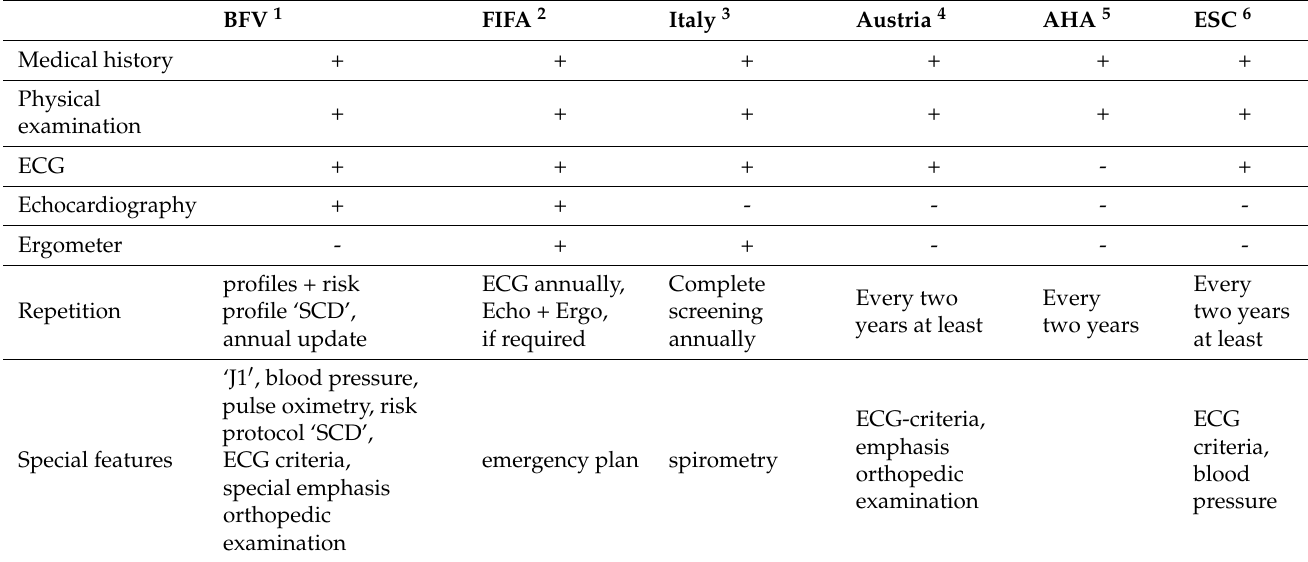
Table 1. Overview of different preventive sports medicine